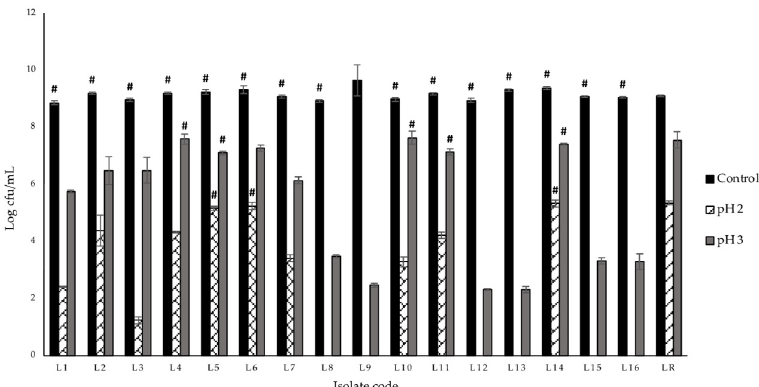
Figure 2. Survival rates of isolates after 3 h of exposure to acidic conditions. (Isolate code: L1–L16: Leuconostoc mesenteroides subsp. mesenteroides , LR: Lactobacillus reuteri Protectis DSM17938). The results are expressed as a mean ± SD of three independent experiments. Data points denoted with a # bear no statistically significant difference to